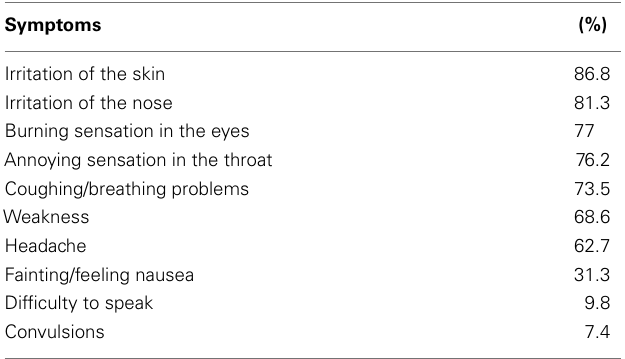
Table 4 | Self-reported types of medication and home remedies used in the last 12months